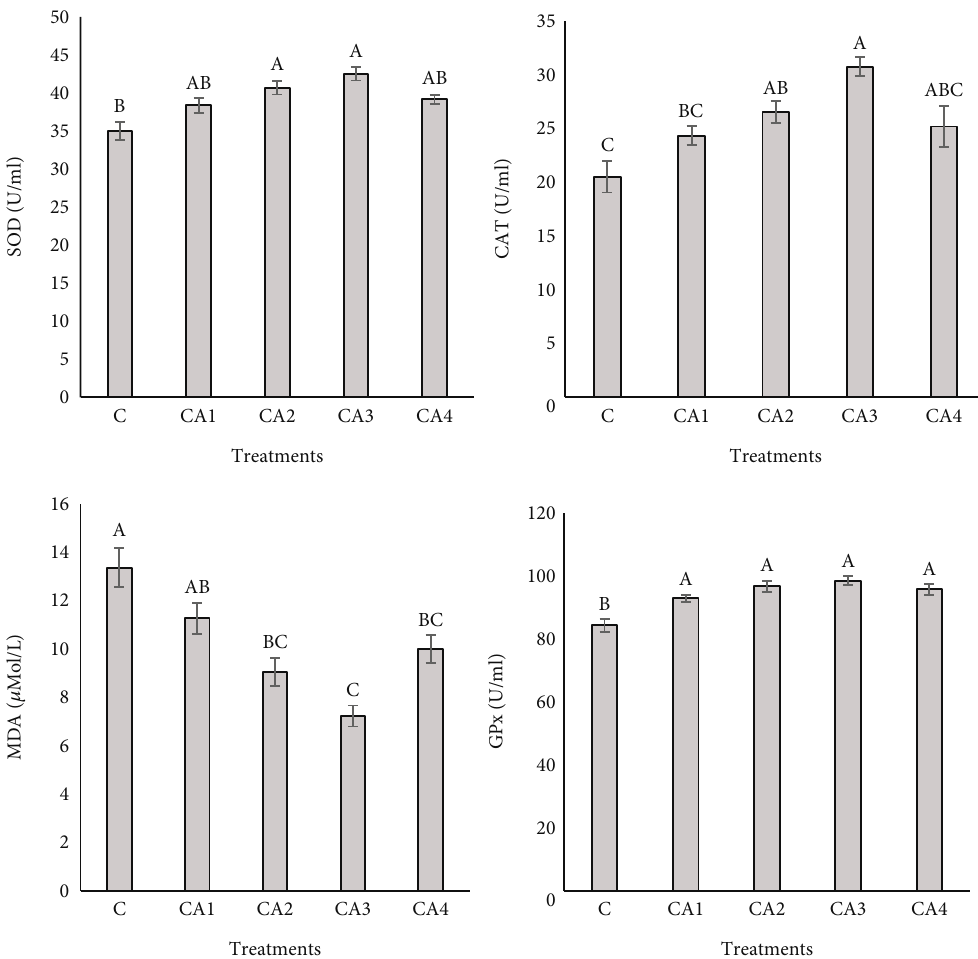
Figure 3: Serum antioxidant activity of O. mykiss fed with di ff erent levels of ChA for 60 days. Columns assigned with di ff erent superscripts signi fi cantly di ff er ( P < 0 : 05 ). Values are presented as mean ± SE . CAT: catalase; SOD: superoxide dismutase; MDA: malondialdehyde; GPx: glutathione